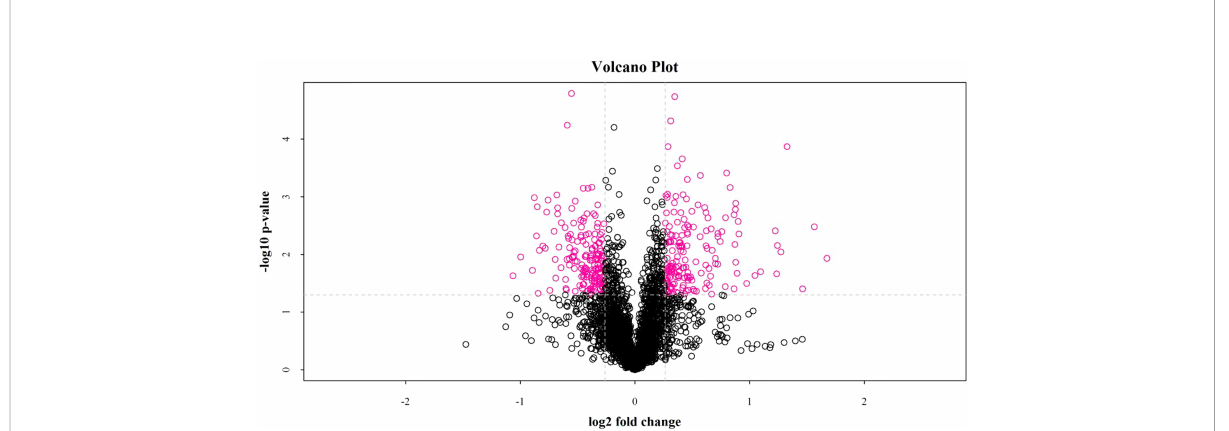
FIGURE 1 The fold change of protein expression between the two groups of samples and the p value obtained by the T test were used to draw a volcano plot to show the signi fi cant difference between the two groups of sample data. The abscissa is the difference fold (the logarithmic change with the base of 2), the ordinate is the signi fi cant p value of the difference (the logarithmic transformation with the base of 10), and the red dots in the fi gure are the signi fi cantly differentially expressed proteins, and the black dots are the proteins with no